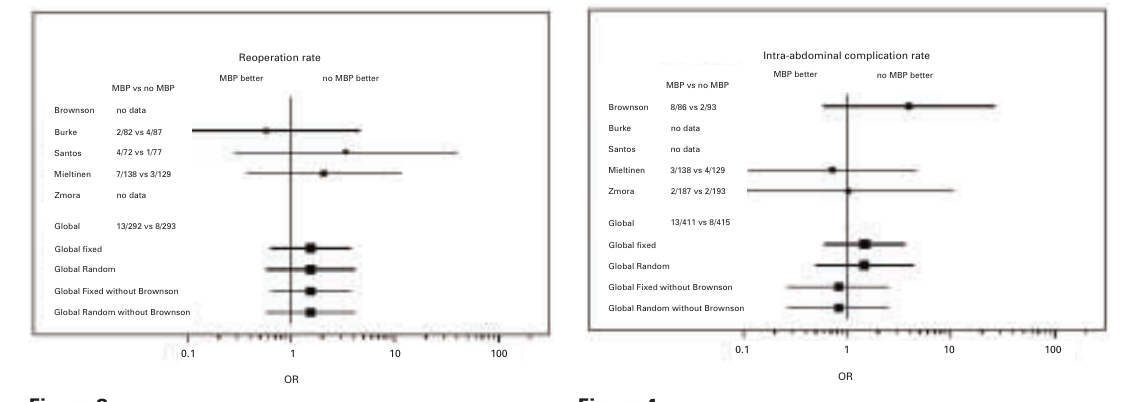
Figure 3 Re-operation rate (odds ratio >1 favours No MBP).